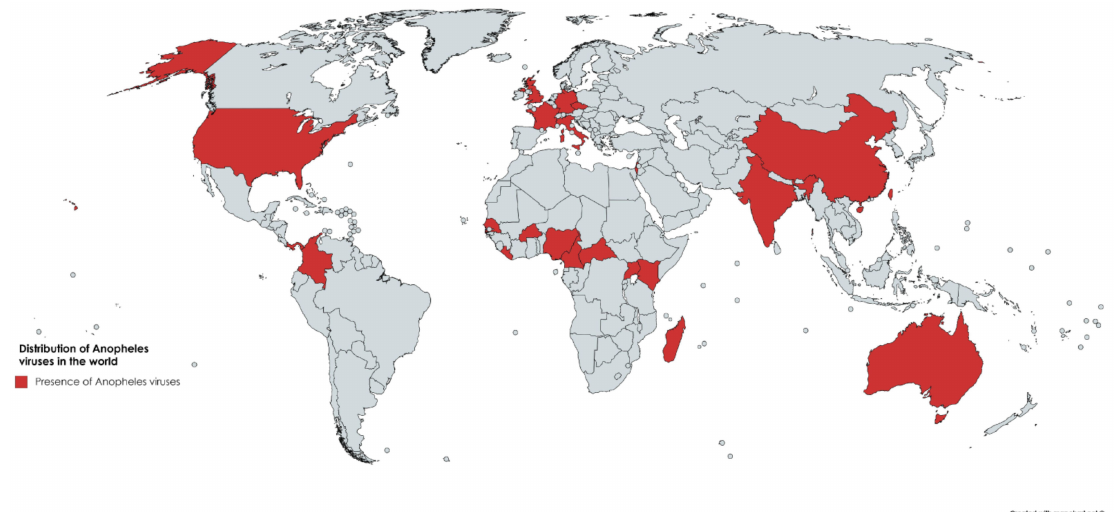
Figure 1. Global distribution of reported Anopheles viruses by country (red, countries with viruses in Anopheles